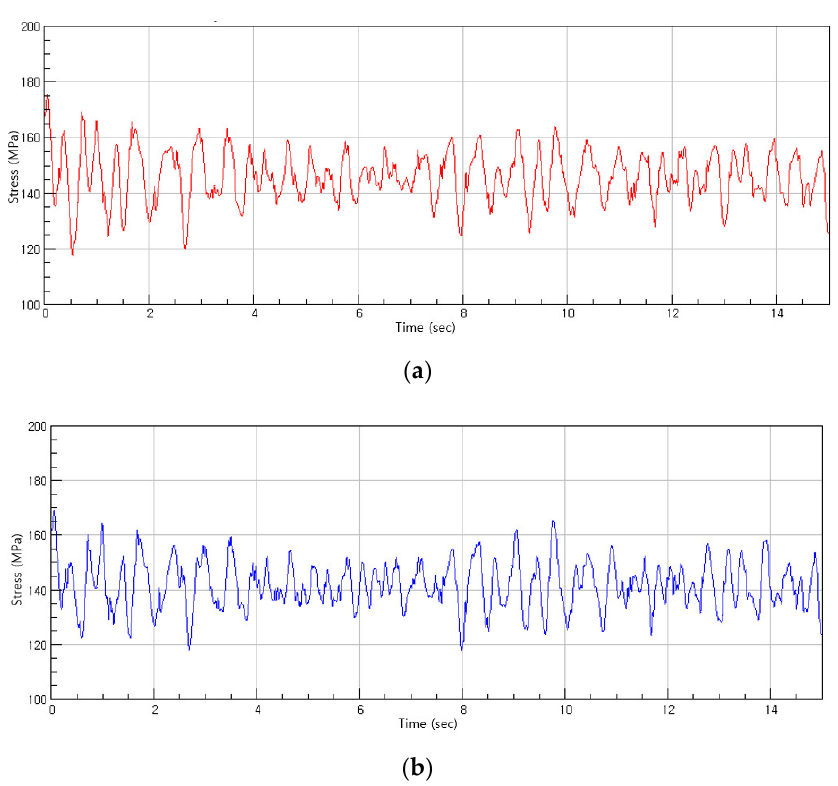
Figure 11. Measured stress at each fastening device when loading part lifted: ( a ) fastening device 1; ( b ) fastening device 2.